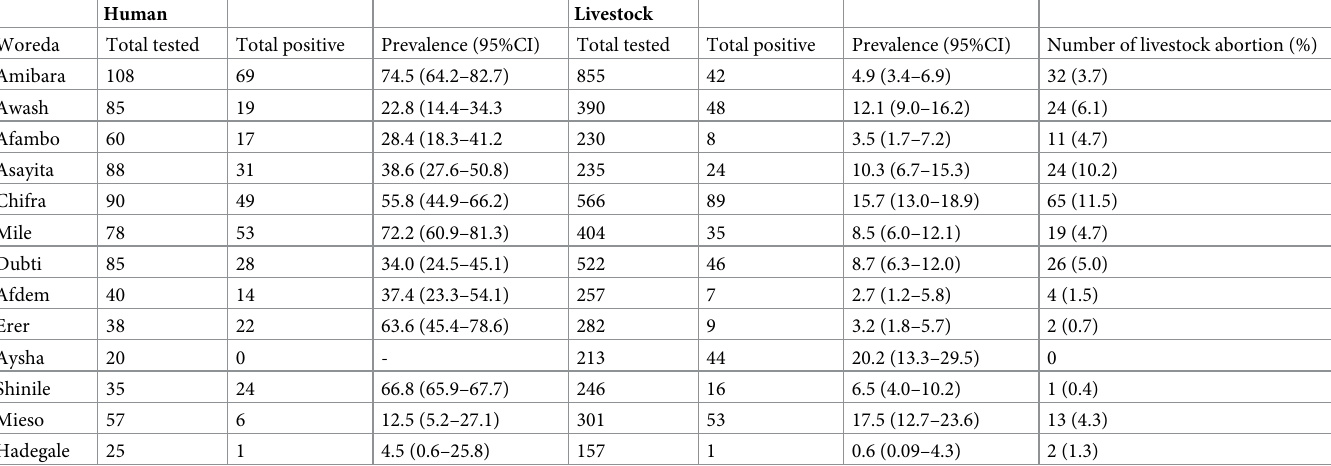
Table 2. Livestock and human prevalence by woreda (random effect on household/herd level).